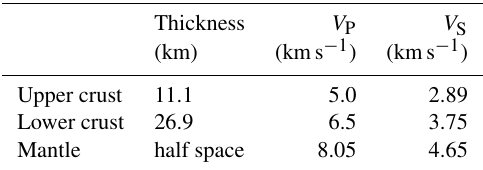
Table B1. P- and S-wave velocity model used in the location pro- cedures for the Italian Seismic